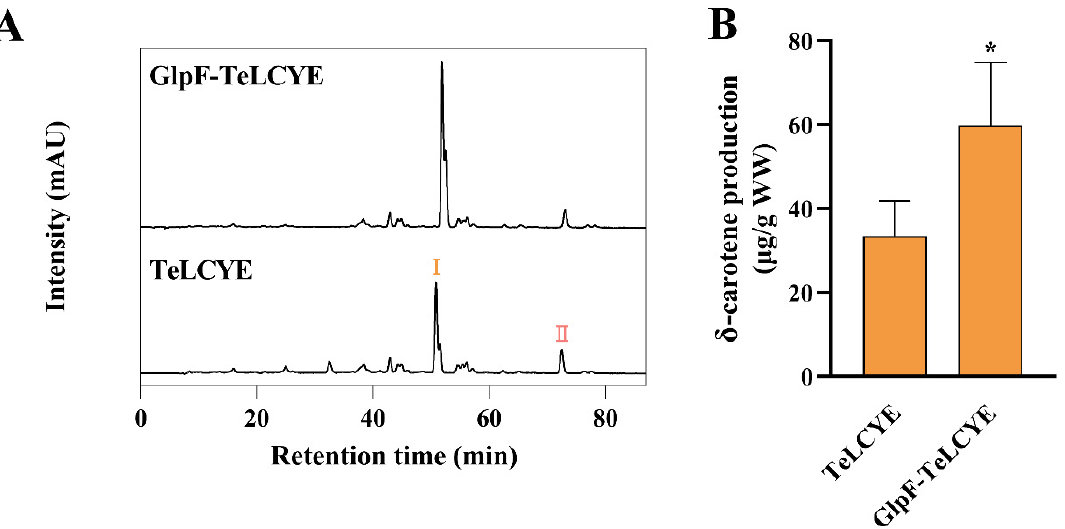
Figure 3. Enhanced catalytic activity of TeLCYE by membrane targeting in lycopene-accumulating E. coli . ( A ) HPLC spectra of XL-1 Blue strains harboring pBlue- GlpF - TeLCYE or pBlue- TeLCYE sepa- rately co-transformed with pAC-LYC. I, δ -carotene; II, lycopene. ( B ) δ -Carotene-accumulation pat- terns in XL-1 Blue strains harboring pBlue- GlpF - TeLCYE or pBlue- TeLCYE separately co-transformed with pAC-LYC. (*) p < 0.05.